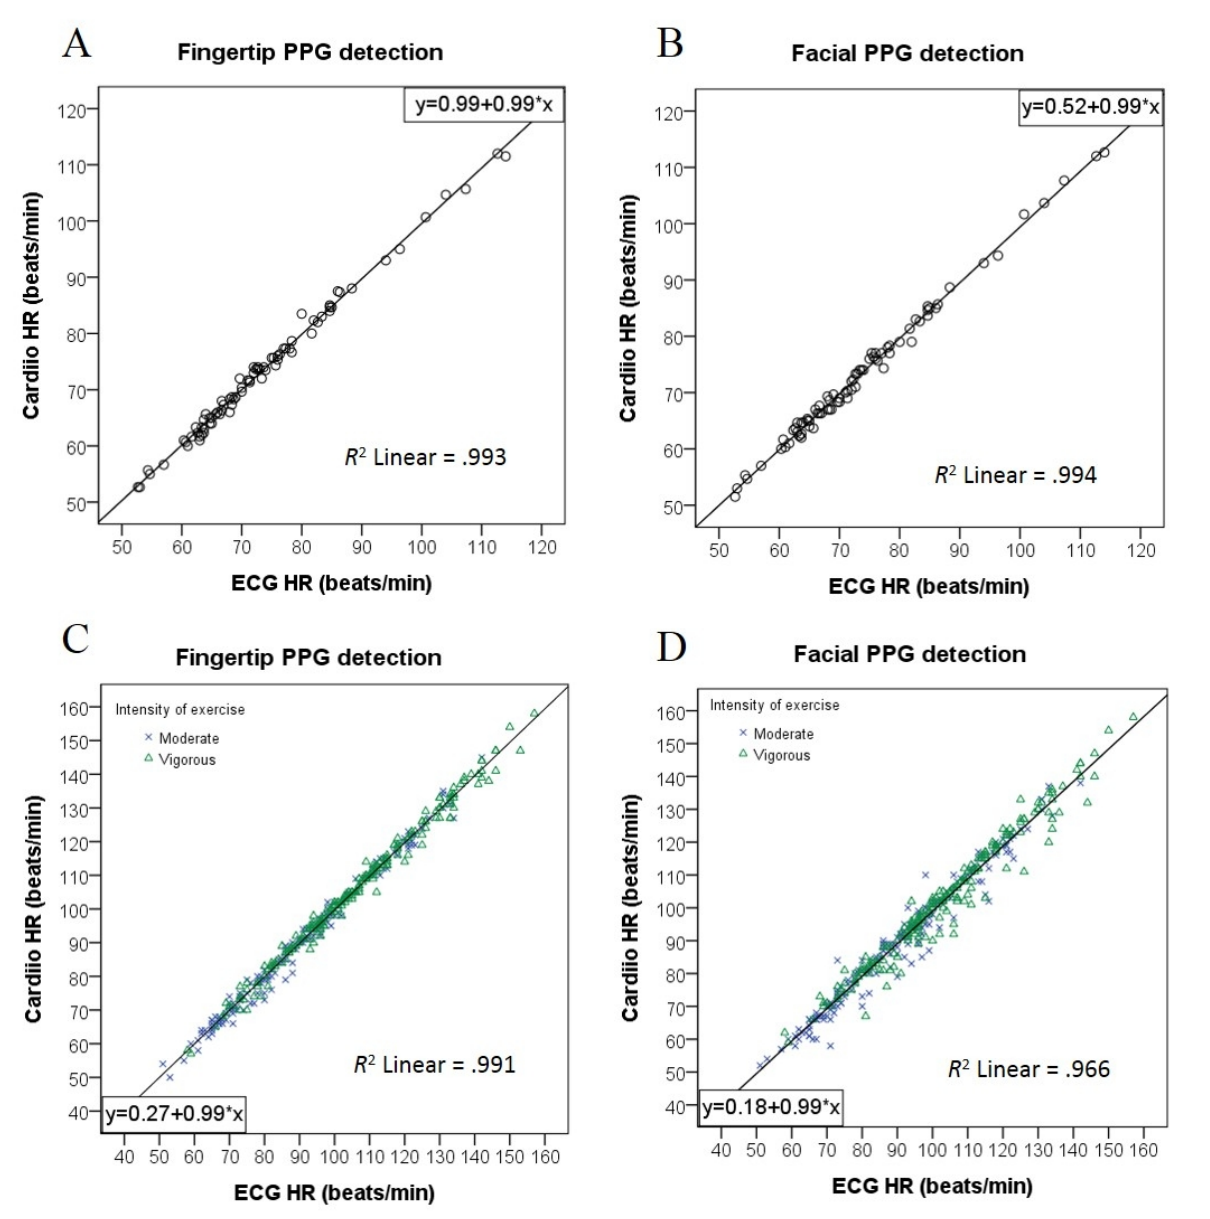
Figure 2. Scatter plots comparing measurements of heart rate (HR) estimated from the Cardiio smartphone phone app photoplethysmographic (PPG) signals and from a reference electrocardiogram (ECG). P <.001 for all correlations. (A) Resting estimated HR from fingertip PPG signals. (B) Resting estimated HR from facial PPG signals. (C) Postexercise HR from fingertip PPG signals. (D) Postexercise HR from facial PPG